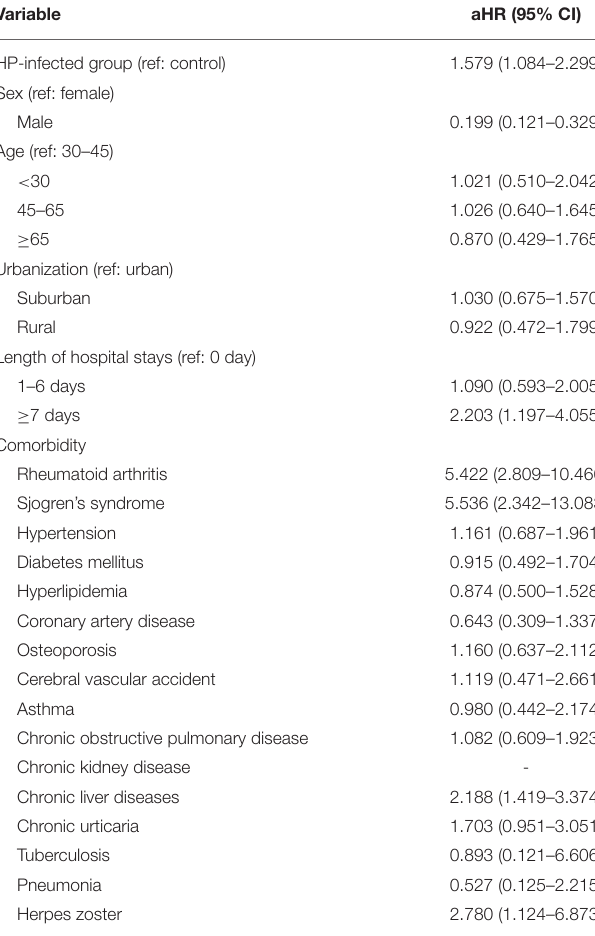
TABLE 3 | Multiple Cox proportional hazard regression for the estimation of adjusted hazard ratios (aHRs) on systemic lupus erythematosus